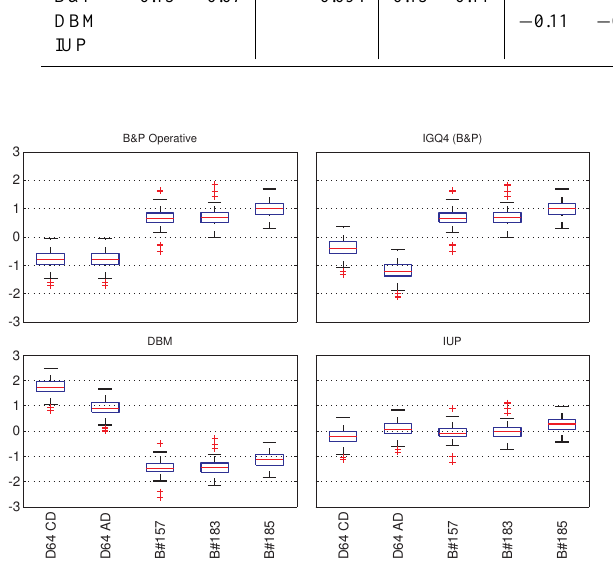
Fig. 9. Daily mean of the Dobson–Brewer total ozone difference for Arosa 2003–2006 and effective temperature. Brewer 040 (B040) is a single-monochromator instrument, while Brewer 156 (B156 )is a double-monochromator